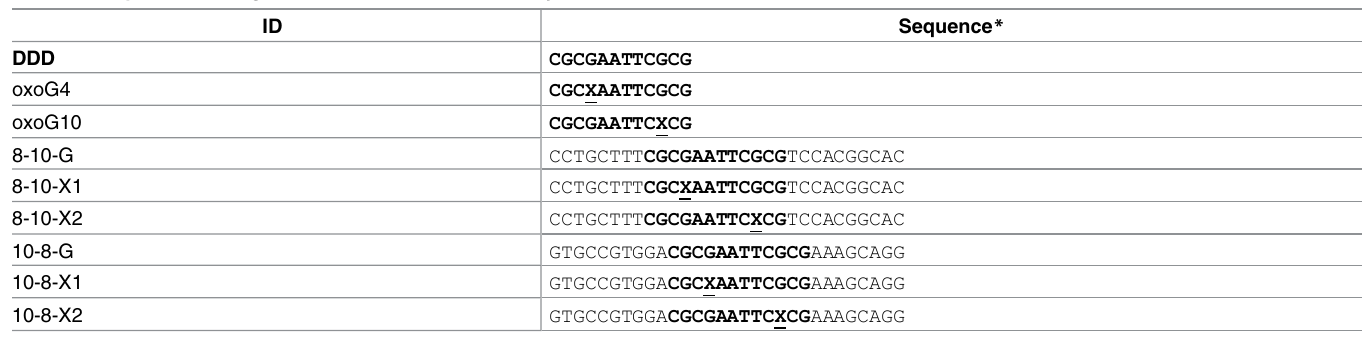
Table 1. Sequences of oligonucleotides used in this